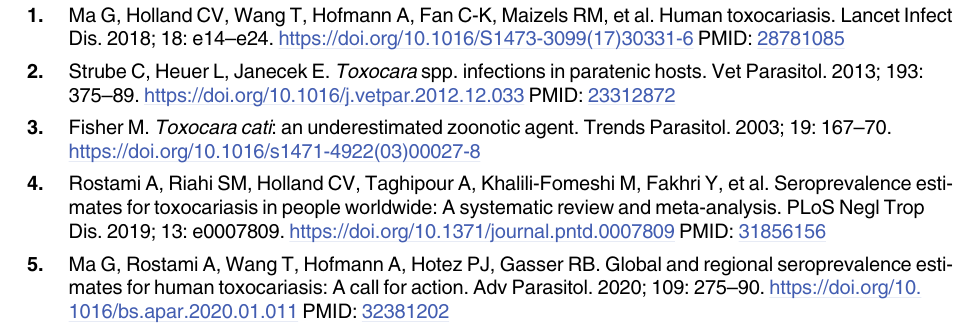
S4 Fig. Western blot analyses of the expression of HA-tagged proteins of RAW264.3 and FLAG-tagged Tc -MUC-1 in transfected HEK 293T cells. Lanes 1–7: PRDX1, PFN1,